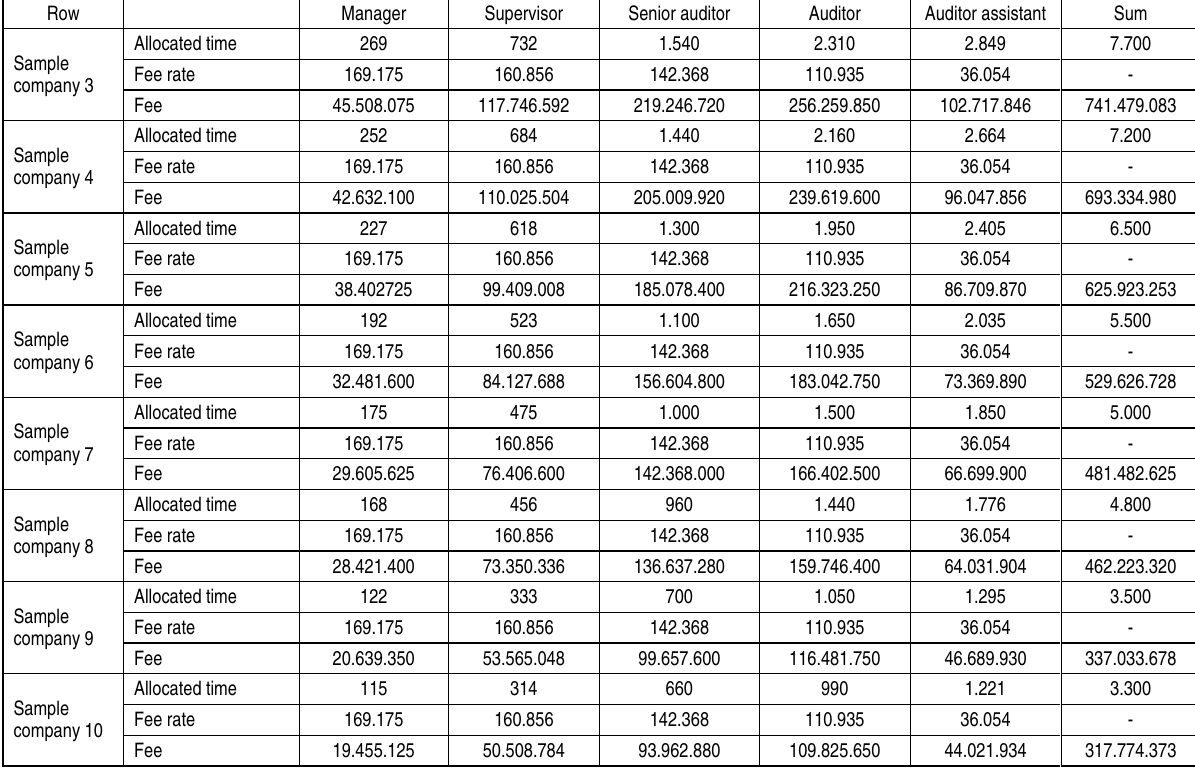
Table 12 (cont.). How to calculate the auditing team employees in 10 sample companies